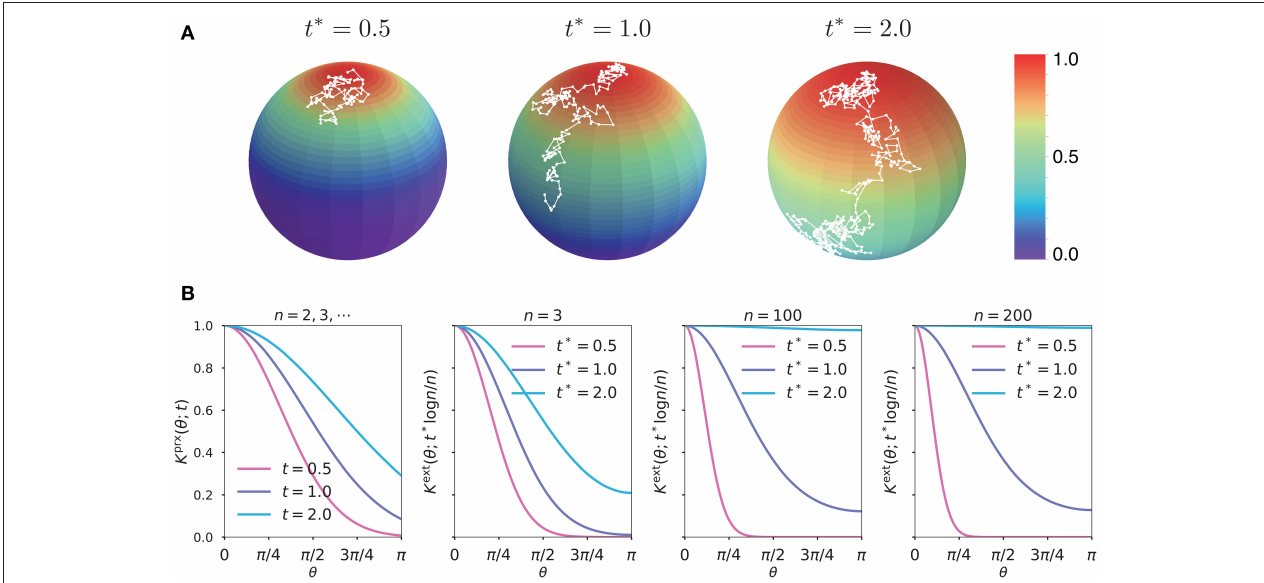
0.5,1.0,2.0; the white paths are simulated random walks on S 2 with the Monte Carlo =